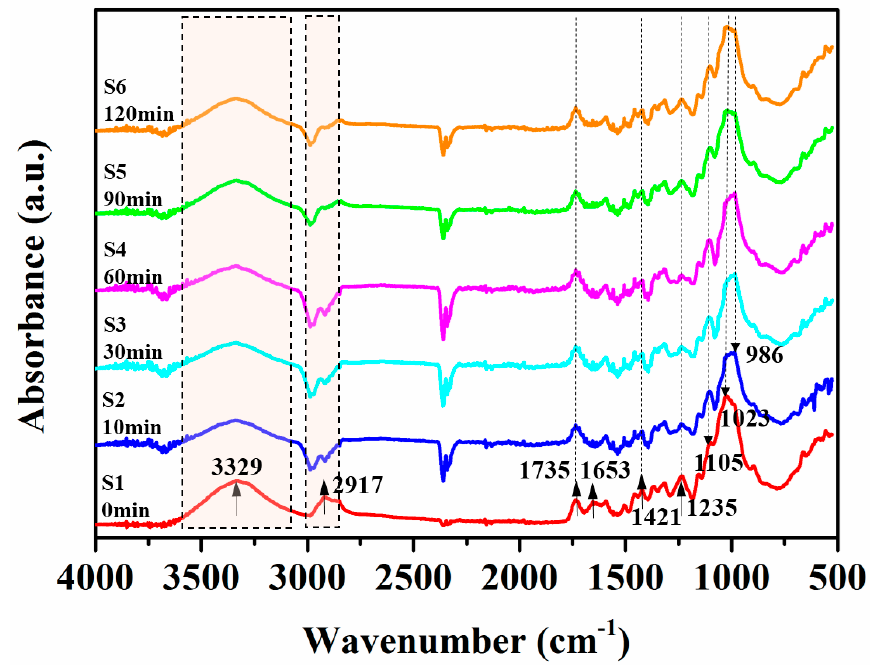
Figure 3. Fourier transform infrared (FTIR) spectra of unmodified and KH-560-modified jute fabrics. Table 1. Peak positions and assignments in FTIR spectra of unmodified and KH-560-modified jute fabrics following different KH-560 modification time durations.